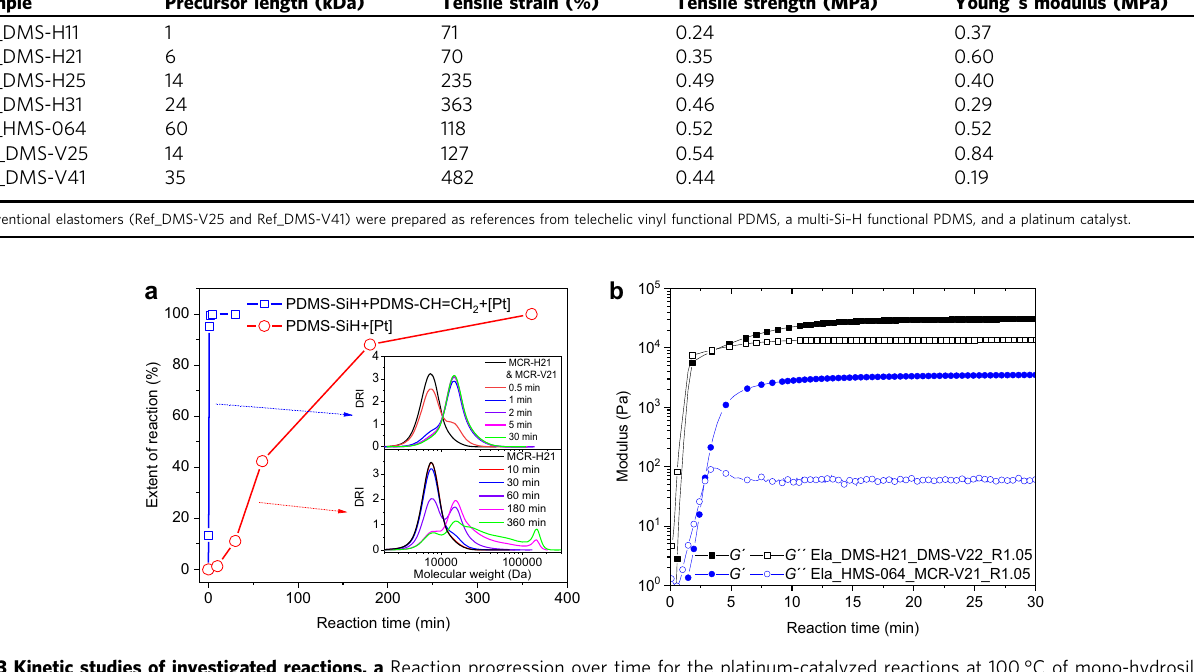
Fig. 3 Kinetic studies of investigated reactions. a Reaction progression over time for the platinum-catalyzed reactions at 100 °C of mono-hydrosilane functional PDMS, and mono-hydrosilane functional PDMS with mono-vinyl functional PDMS (stoichiometric amounts of hydride and vinyl). The extents of reaction were determined based on 1 H NMR spectra (Supplementary Fig. 4). The inserts show molecular weight distributions over time during the two reactions. b Dependence of storage and loss moduli ( G ´ and G ´´) of representative highly stretchable and extremely soft silicone elastomers on curing time measured at 100 °C, 1 Hz, and with a fi xed strain of